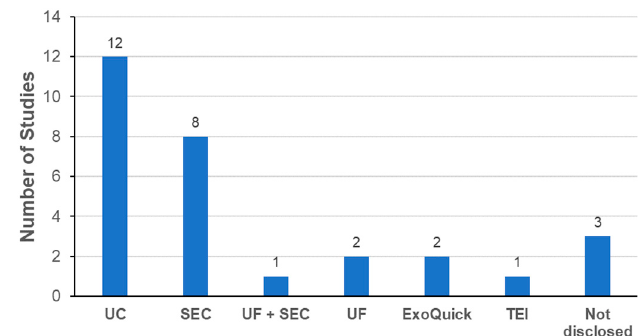
Figure 6. Methods to remove unlabeled probes from labeled exosomes.